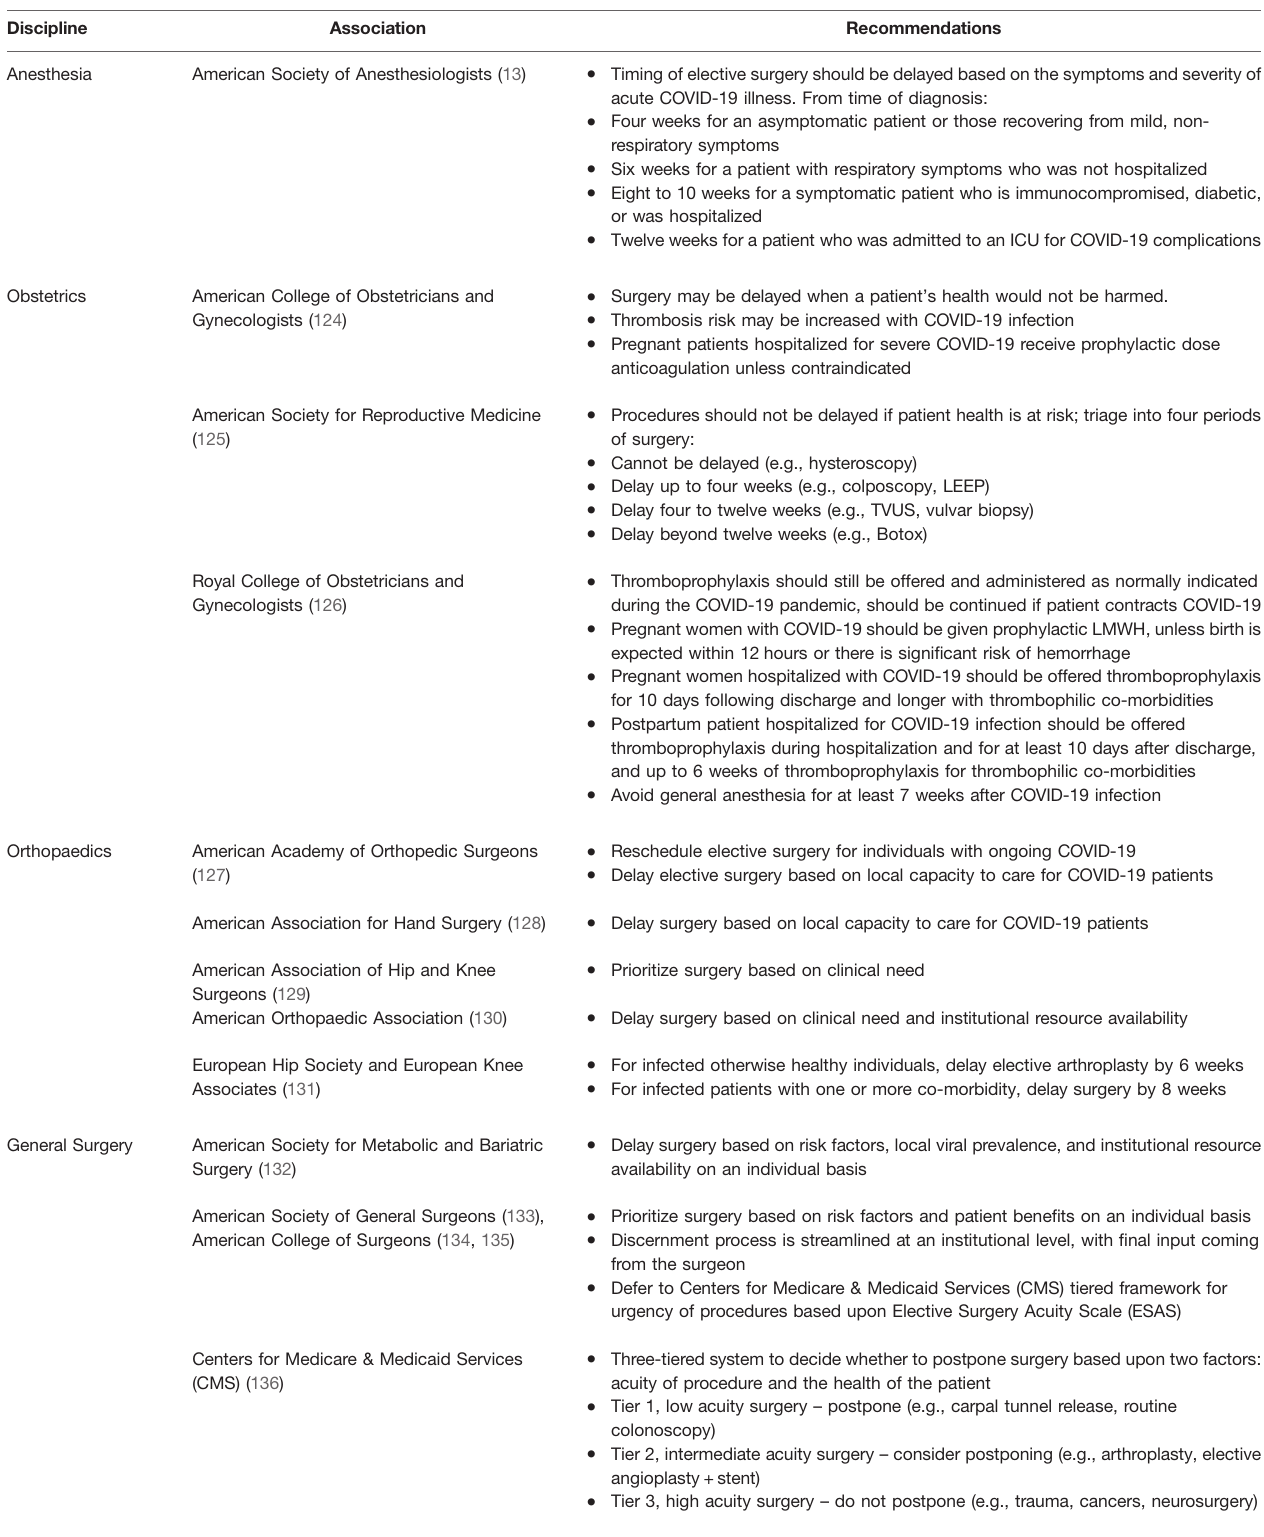
TABLE 2 | Society recommendations on timing of surgery and thromboprophylaxis in acute and convalescent COVID-19 patients. Note this table is not exhaustive, but re fl ects the diverse and heterogeneous recommendations regarding the timing of surgery and anticoagulation for this patient